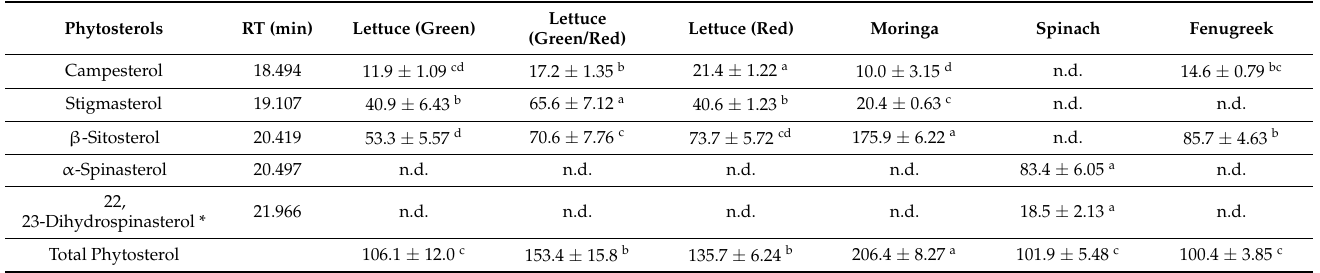
Table 5. The phytosterol contents ( µ g/g FW) in studied